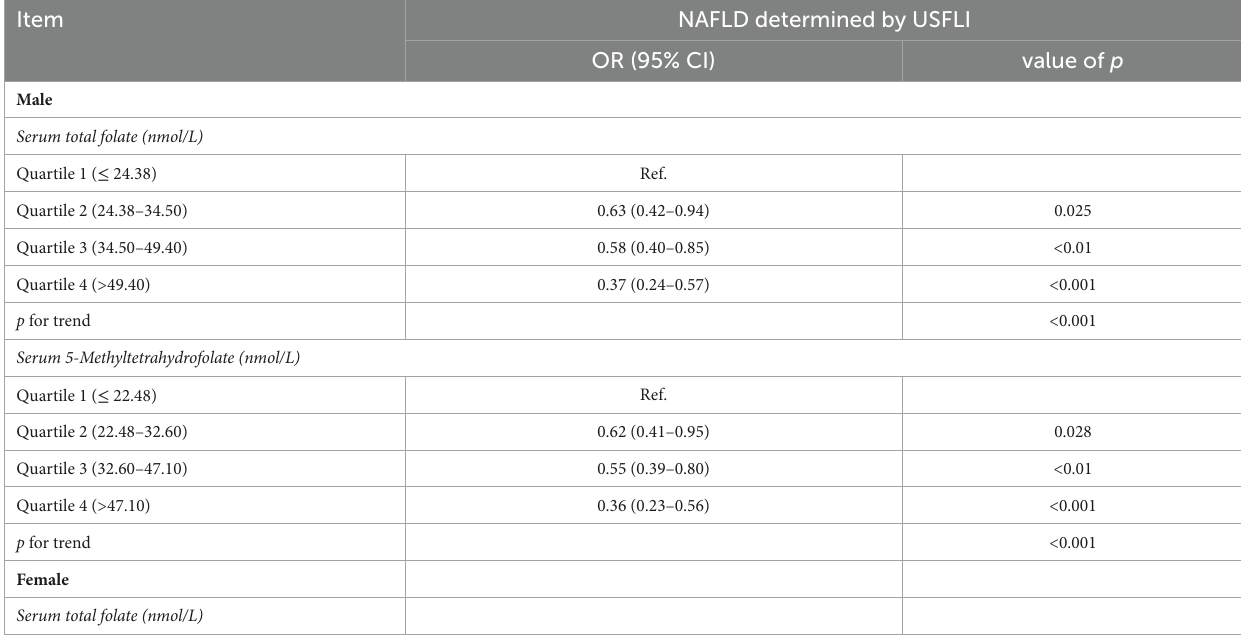
TABLE 3 Associations between serum total folate and 5-Methyltetrahydrofolate levels with NAFLD stratified by gender in NHANES 2011–2018. Item NAFLD determined by USFLI OR (95% CI) value of